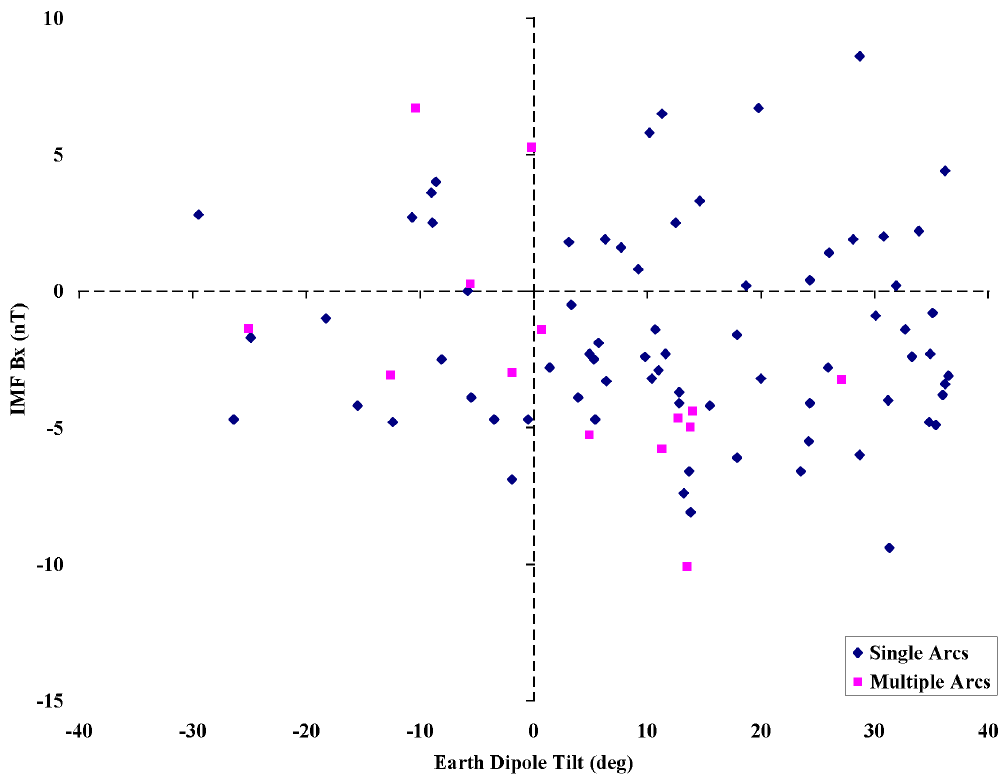
Fig. 6. IMF B x versus Earth dipole tilt for single arcs and multiple distinct thin